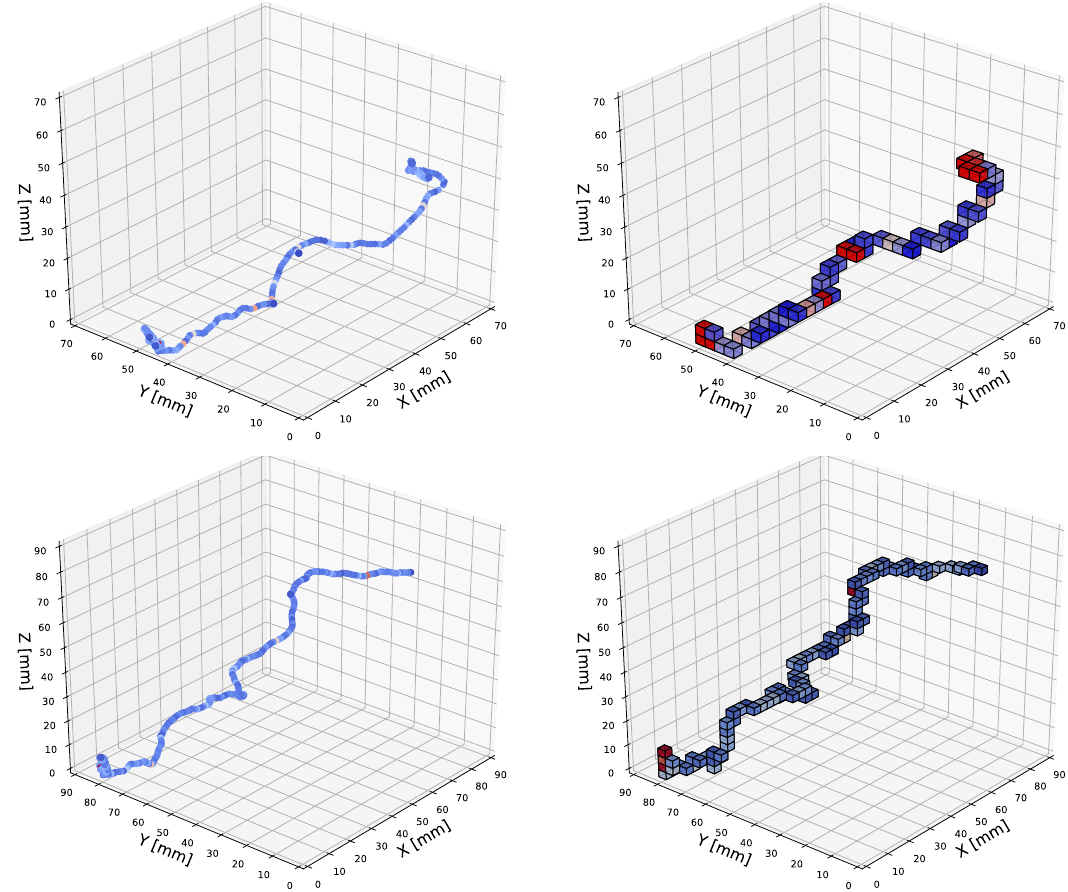
Figure 3 . Monte-Carlo simulation of a 0 νββ decay of 136 Xe (top row) and of an electron track of the same energy (bottom row) in gaseous xenon at 15 bar . Below the so-called critical energy (about 12 MeV in gaseous xenon), electrons lose their energy at a relatively fixed rate until they become non-relativistic; at about that time, they lose the remainder of their energy in a relatively short distance, generating a blob . Therefore, the ionization tracks left by 0 νββ events, consisting of two electrons emitted from a common vertex, feature blobs at both ends. Single-electron tracks, the main background in NEXT, only have one blob. In the left column, the tracks are shown as generated by our simulation, whereas in the right the energy deposits have been binned into 3 × 3 × 3 mm 3 voxels to account for the effect of charge diffusion in a gas with a low-diffusion